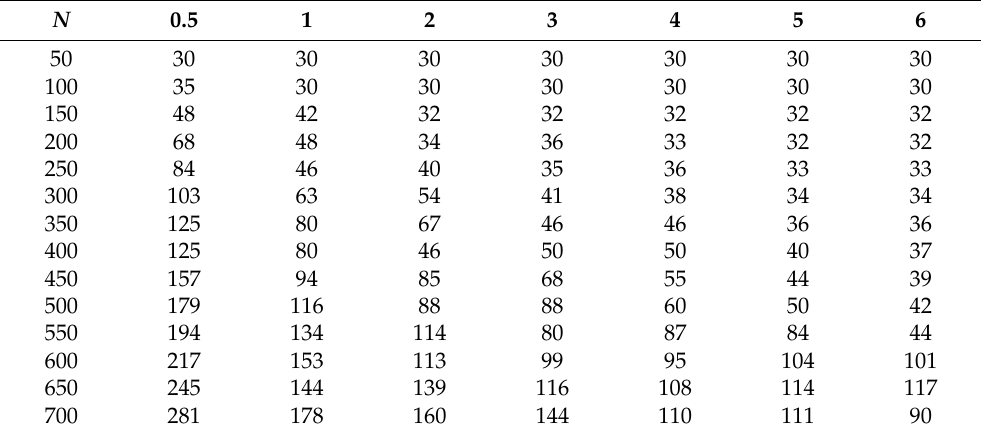
Table 8. The relationship between the number of evacuees and EDRT when D max is different.